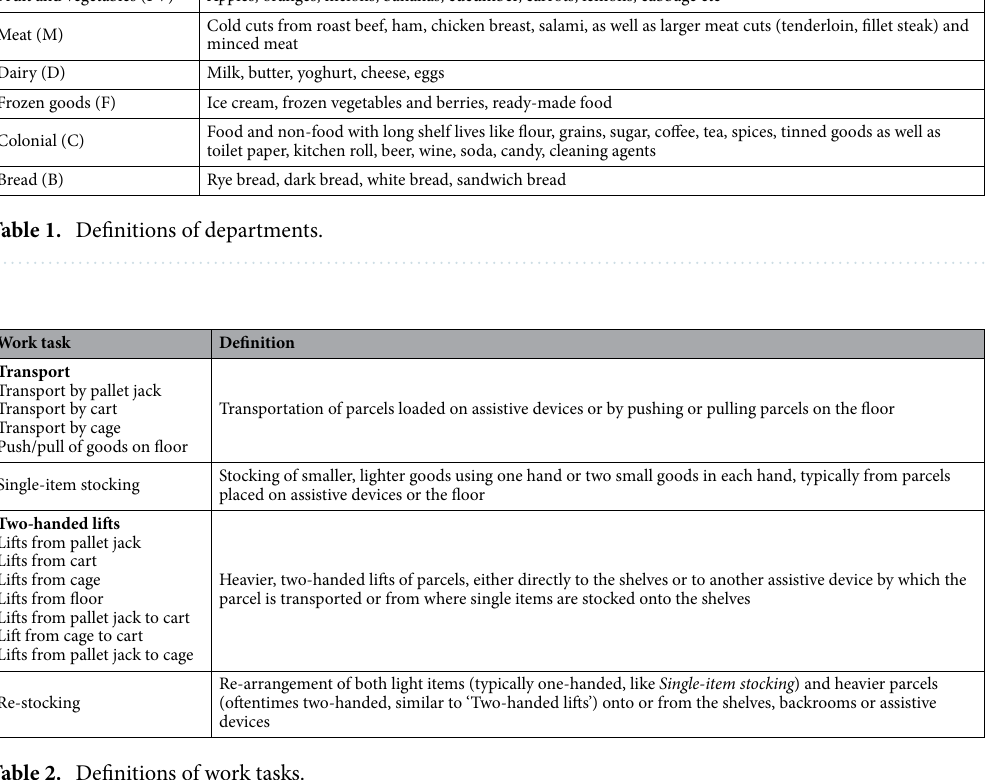
Table 2. Definitions of work